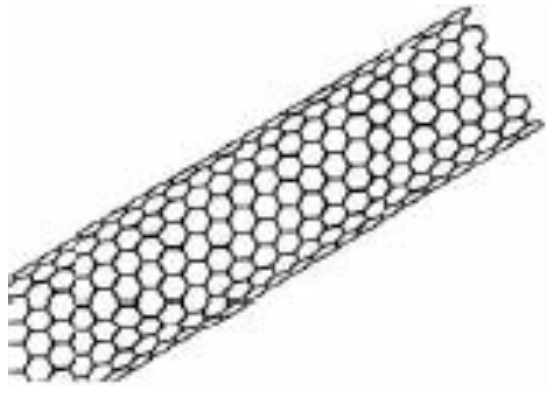
Figure 2. An armchair polyhex nanotube [19].